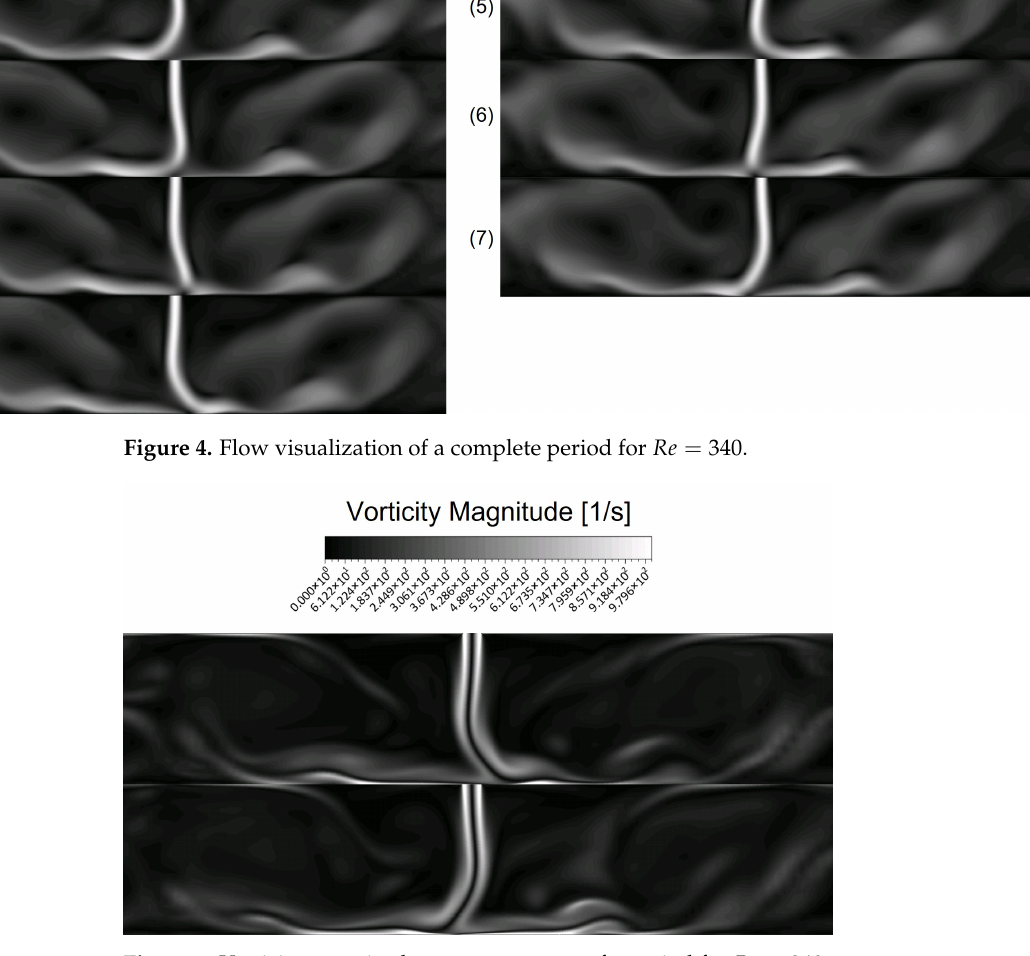
Figure 5. Vorticity magnitude at two extremes of a period for Re =